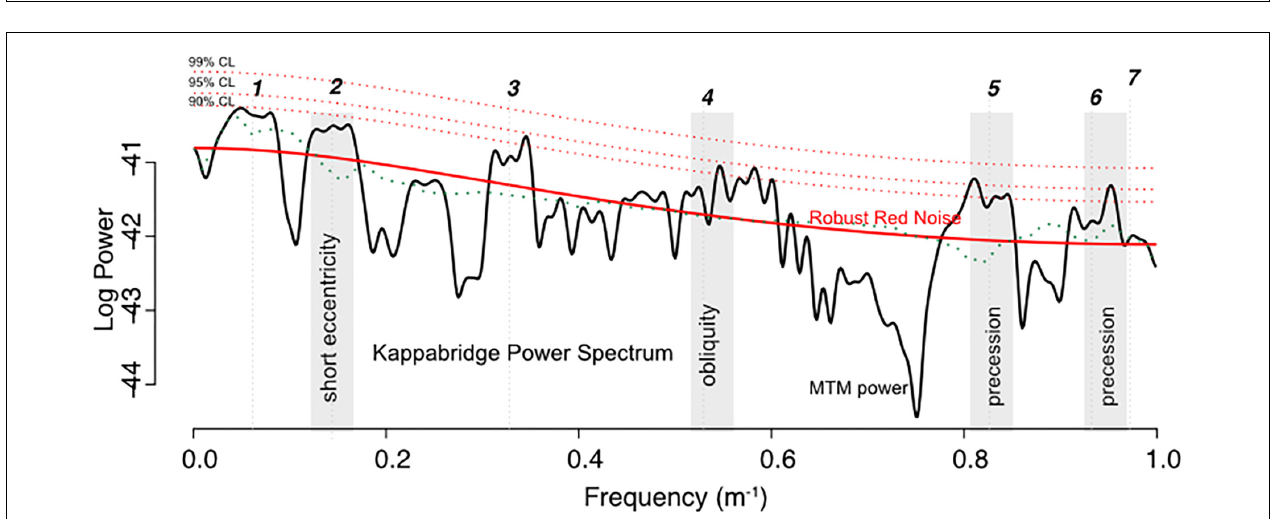
FIGURE 4 | Log power spectrum for the SM-20 portable susceptibility meter magnetic susceptibility time series shown in Figure 3 showing significant peaks chosen by Astrochron (Meyers, 2014) and numbered (confidence limit set to 0.9). The shaded bands show our choice for the Milankovitch cycles. See Table 1 for the periods/frequencies of the numbered peaks.